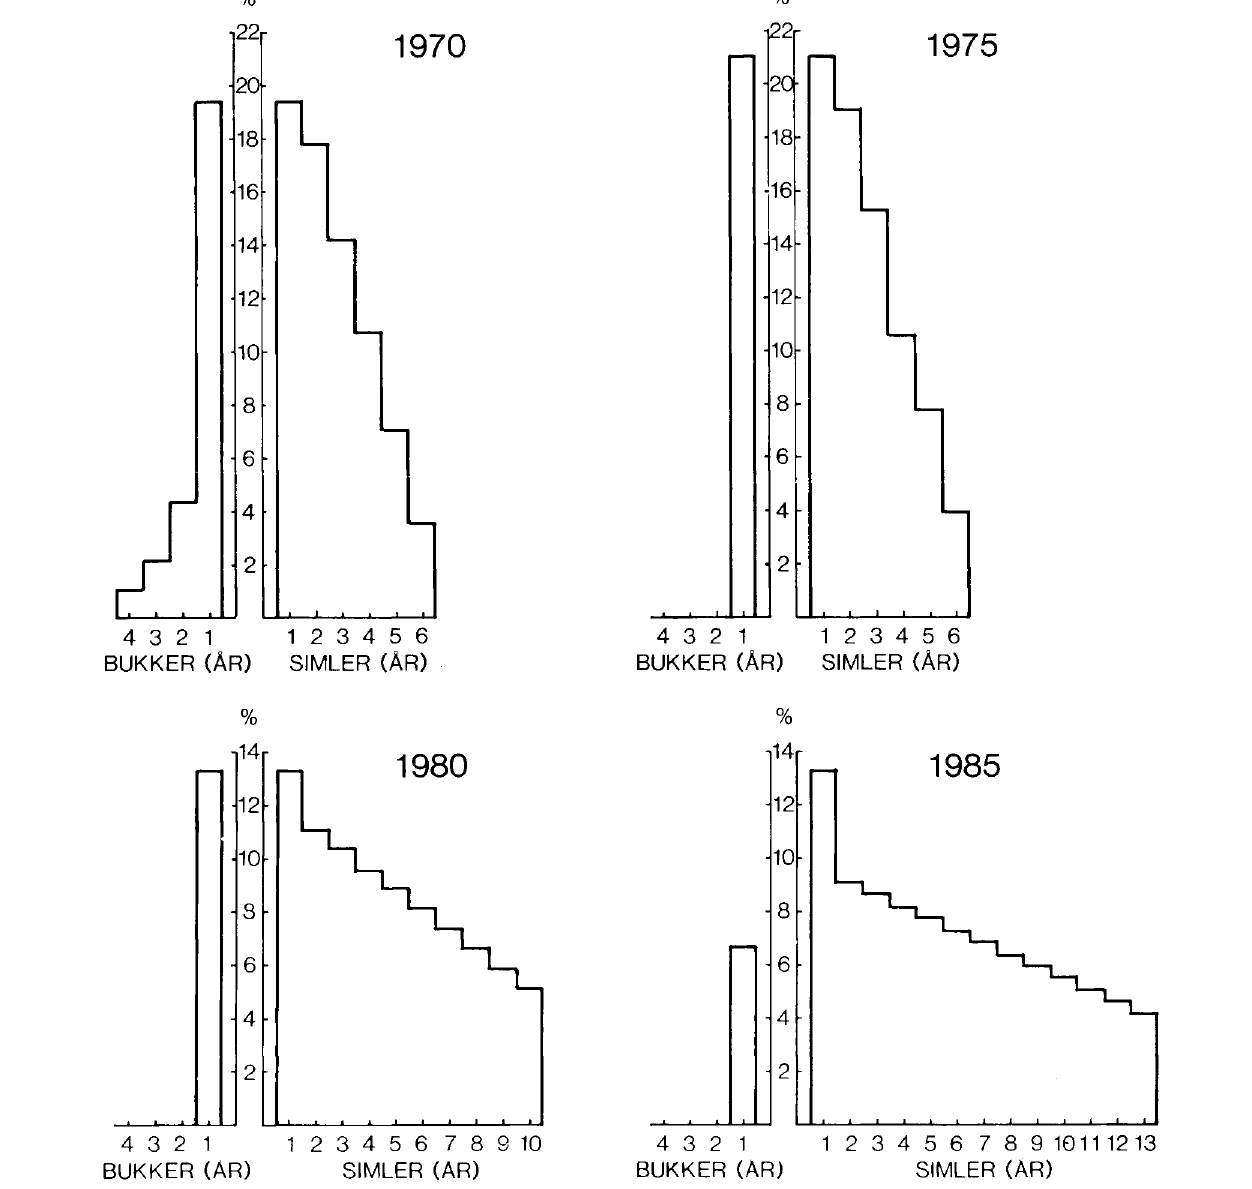
Figur 17. Prinsippskisse for utviklingen av kjønns- og aldersstrukturen innen vårflokken i Riast/ Hylling i pe- roiden 1970-85 (Lenvik